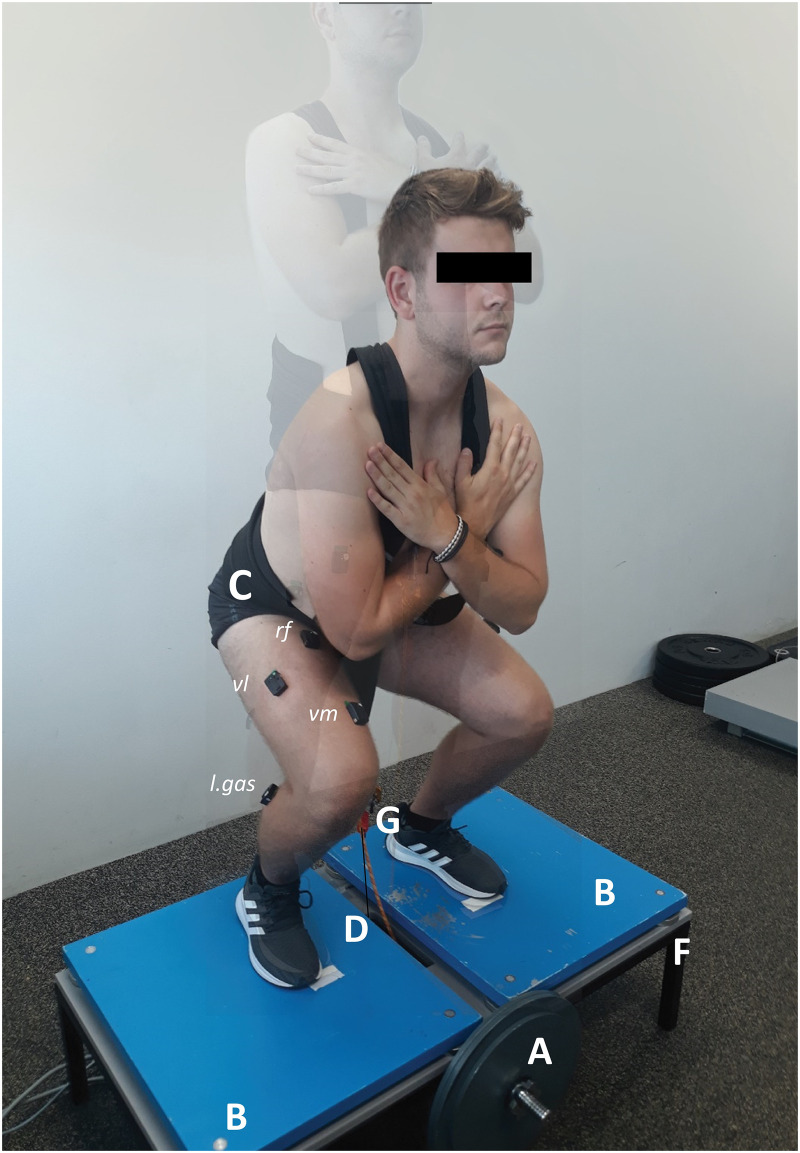
Testing setup.The flywheel (FW) exercise device utilized the inertia of a spinning FW (A) to produce resistance. The FW standing platform (F) with plates (B) size was 1.1 x 0.6 m, rotary shaft diameter was 0.03 m and pulling rope diameter was 0.006 m. A harness (C) was used to aid in performing FW and isometric squats. A draw-wire sensor was installed under the device. The wire originated directly above the center of the axis—to avoid diagonal vertical displacement (D). The distal part of the wire was attached to the harness rope attachment (between legs) (G).